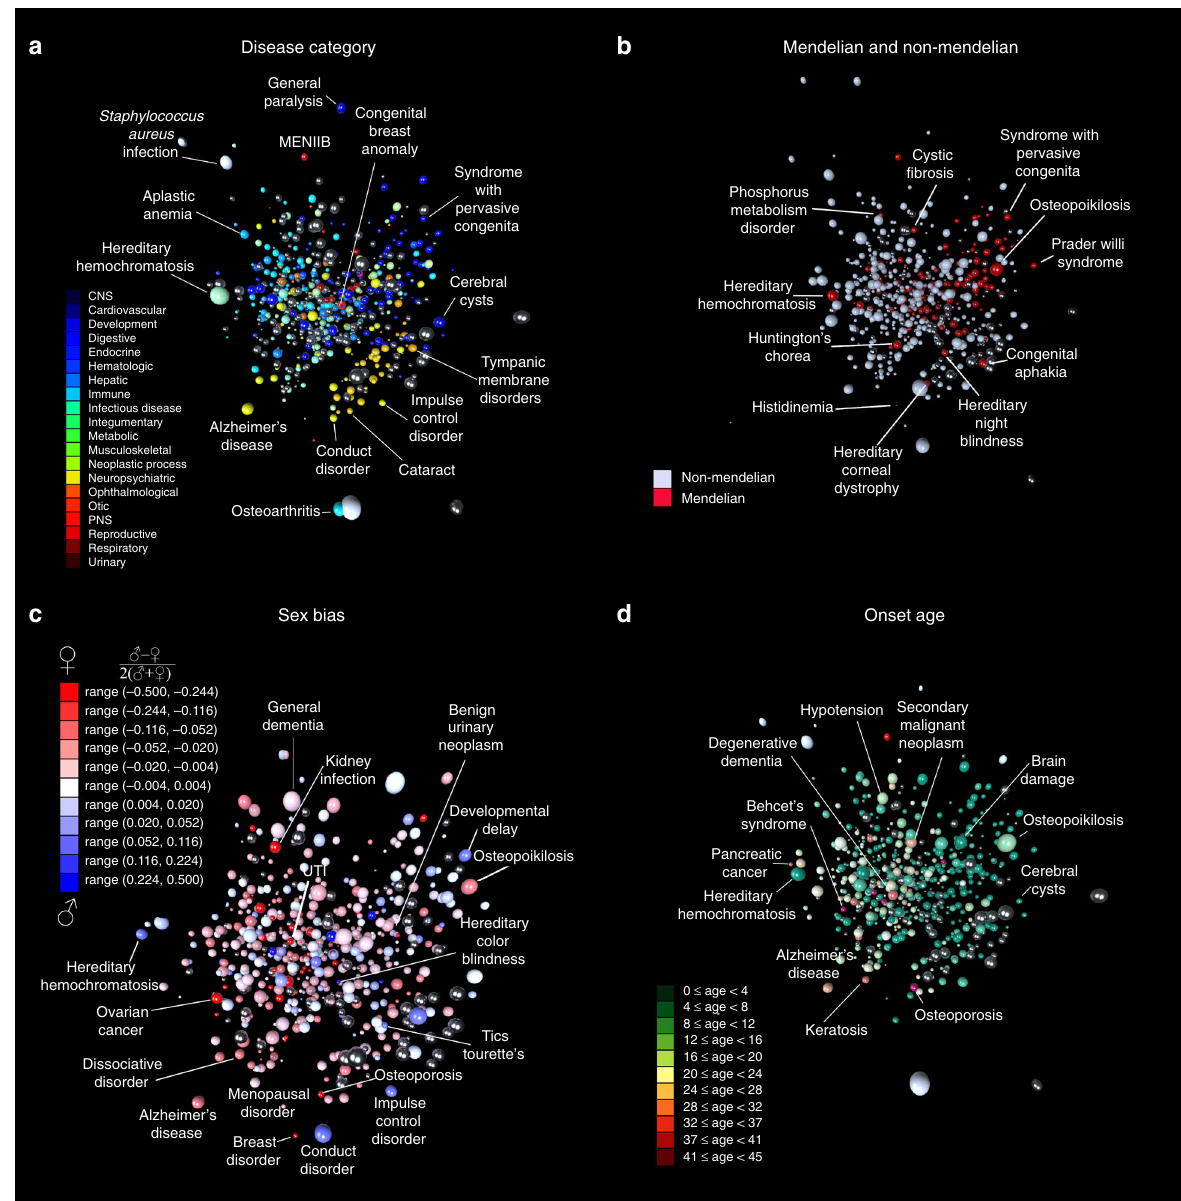
Fig. 2 An embedding disease mapping into metric space positions, with related diseases close to each other. Diseases can be mapped to points in low- dimensional metric space (so-called “ disease embedding ” ). See the three-dimensional projections of our 20-dimensional embedding in ( a ) – ( d ) in this fi gure, where similar diseases are closer to each other in metric space than dissimilar ones. This 20-dimensional disease embedding turned out to be extremely useful in this study for estimating population-genetics parameters for individual diseases. a We projected the 20-dimensional disease embedding vectors of over 500 diseases into 3-dimensional space for ease of visualization, using the t-SNE algorithm 52 . We color-coded the spheres representing the diseases by each corresponding disease category. Plate b shows Mendelian vs. non-Mendelian disease distribution. Plate c shows disease- speci fi c sex bias (de fi ned in such a way that it is 0 for diseases that are equally frequent in males and females, − 0.5 for diseases that occur only in females, and + 0.5 for those occurring only in males). Plate d shows diseases color-coded in accordance with their onset ages, where green colors indicate early- onset childhood diseases, and warmer colors point to later-onset the mean age of fi rst disease diagnosis is approximately bell- shaped but skewed towards younger ages, with onset age mode around 42 years over all diseases (Fig. 3e). The total number of disease assignments is positively correlated with disease onset age (see Methods part 1 for the precise de fi nition; Spearman ’ s cor- relation is ρ = 0.32, p < 10 − 16 computed using algorithm AS 89 (refs. 37,38 ), as shown in Fig. 3f), and individual shape clusters all agree on the positive correlation (Methods part 5, Fig. 3g, and